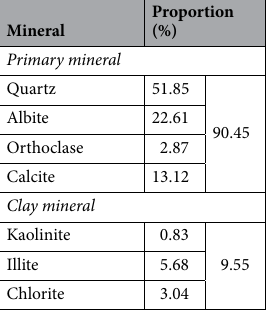
Table 3. The mineral composition of the saline–alkali soils in this study